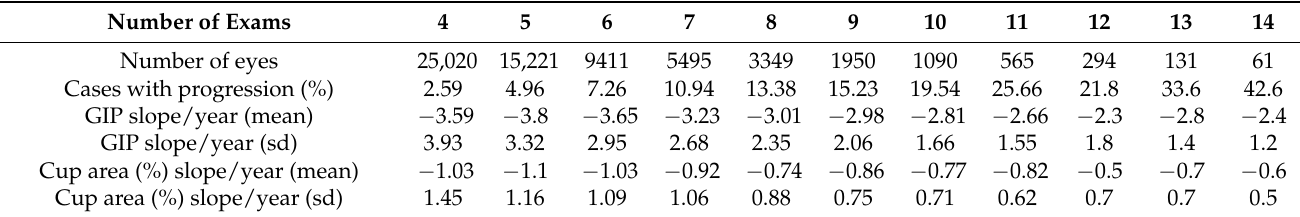
Table 1. Cases with significant progression ( p < 0.01). The percentage of cases that progressed, the slope per year of the GIP index, and the percentage area of the cup in relation to the number of control examinations performed are shown.